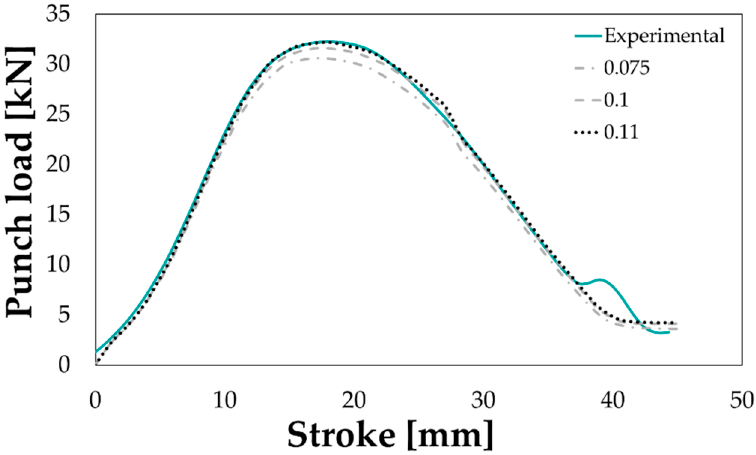
Figure 19. Comparison between the experimental punch load-punch stroke curve and the correspondent numerical ones obtained changing the friction coefficient in the range 0.075–0.11.